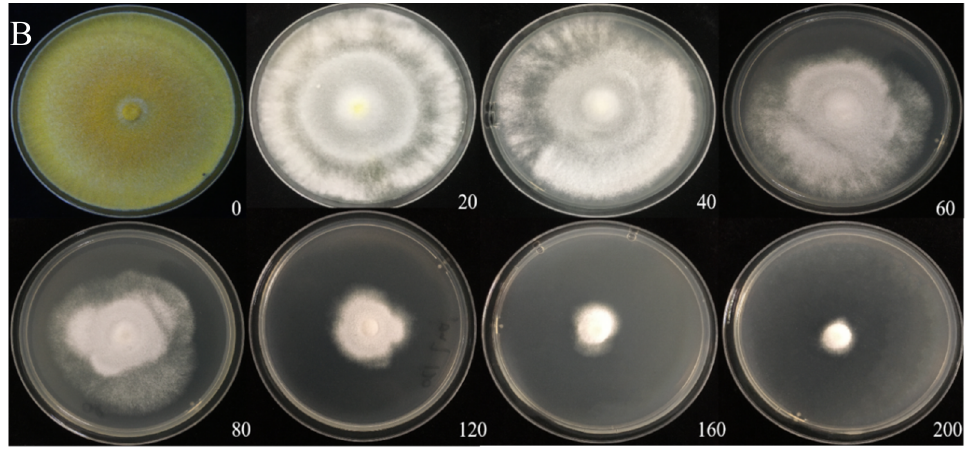
Figure 4. Cadmium tolerance of H. chrysospermus on PDA plates. ( A ) 5 days; ( B ) 10 days. Data in the figure indicate Cd 2+ concentrations (mg · L − 1 ) in PDA.